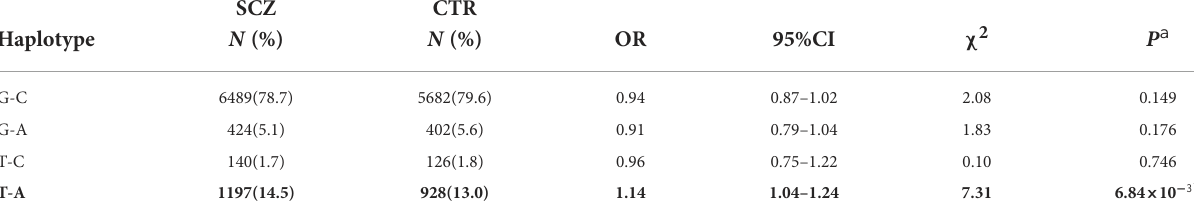
TABLE 3 Association of rs10489202–rs11586522 haplotypes with